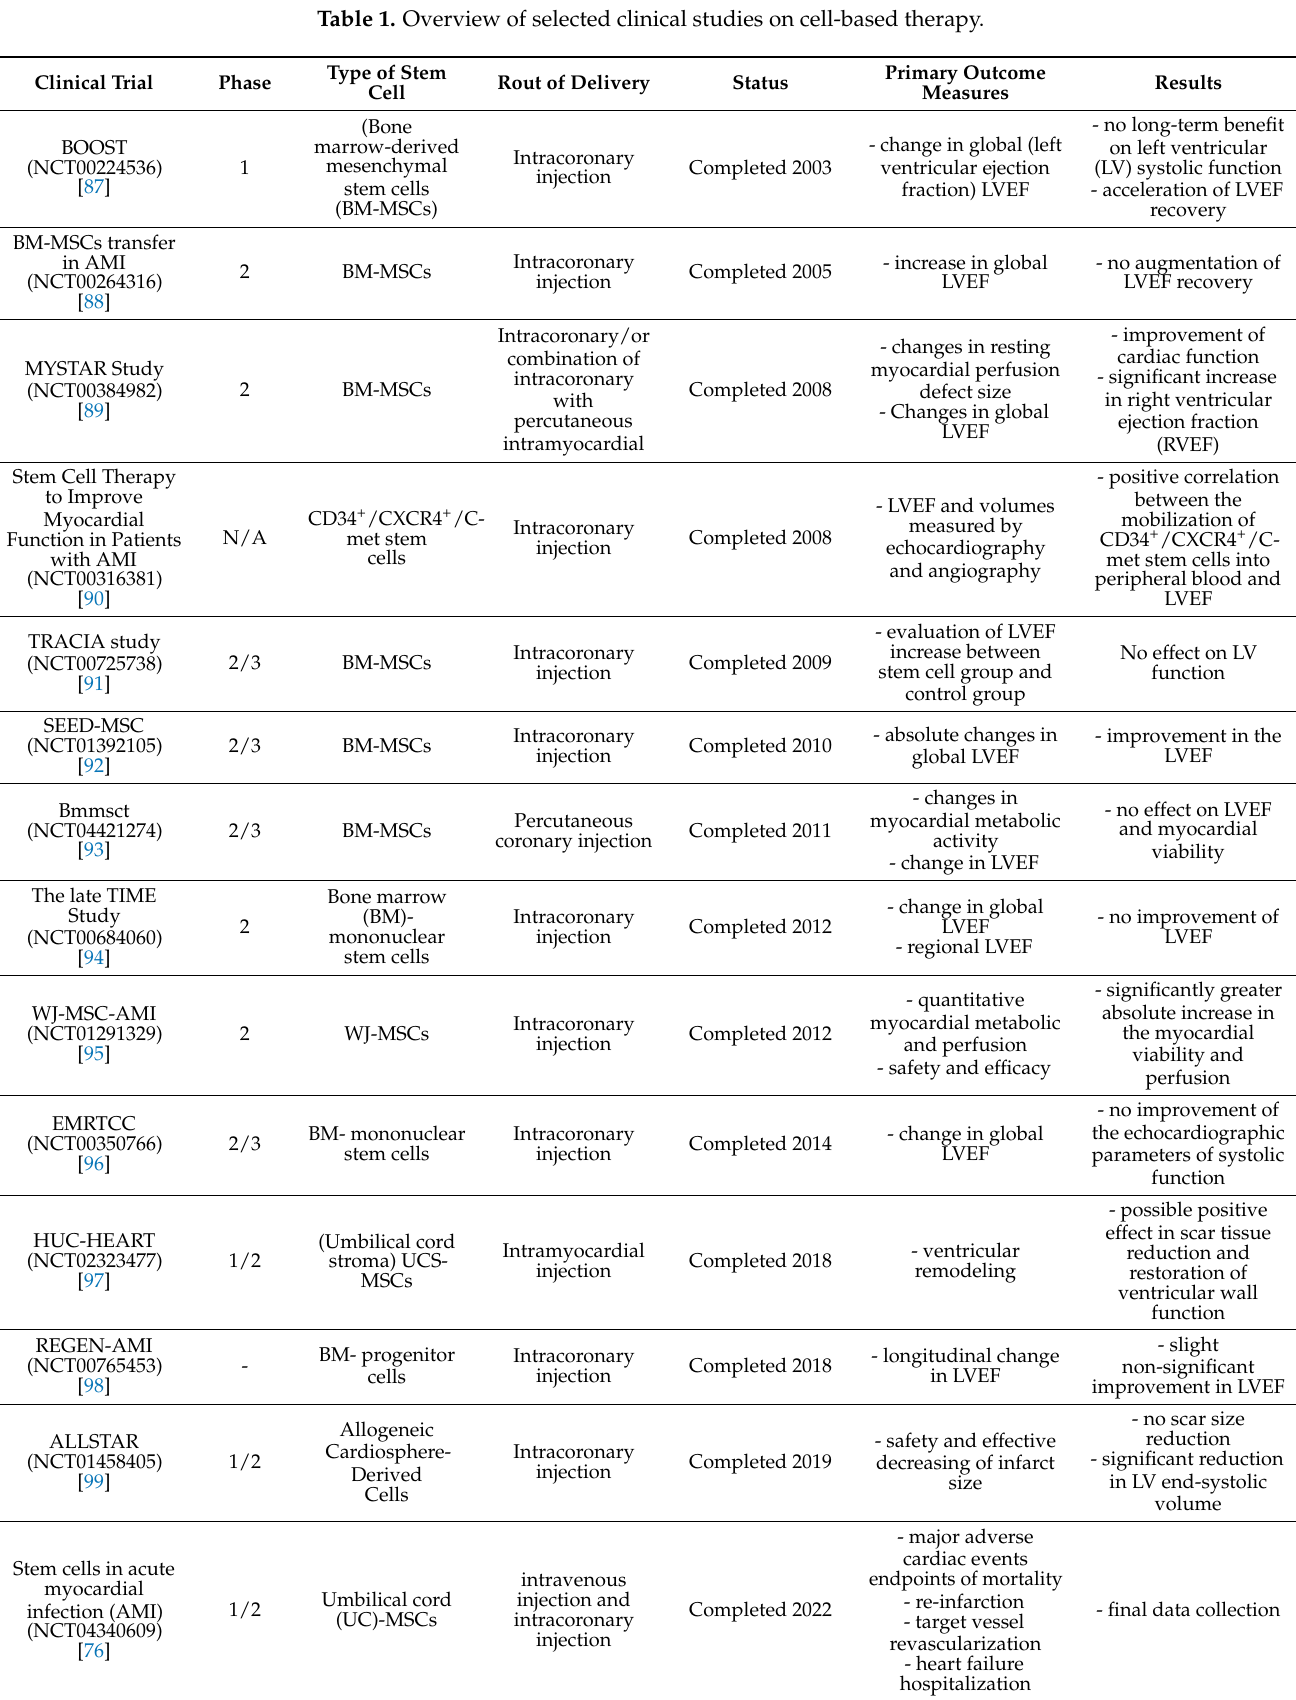
Table 1. Overview of selected clinical studies on cell-based